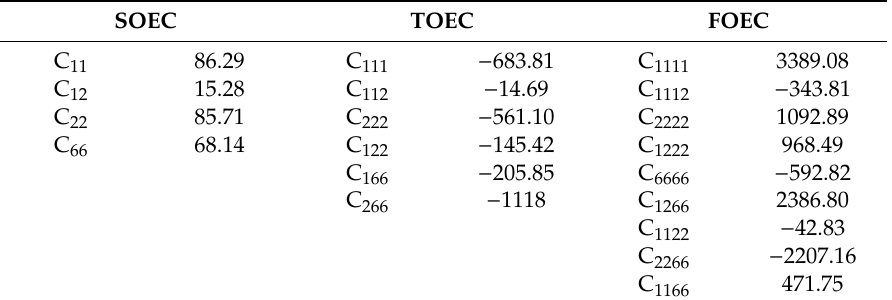
Table 3. Nonzero second-, third- and fourth-order elastic constants (in N / m) for the HfS 2 monolayer. SOEC TOEC FOEC C 11